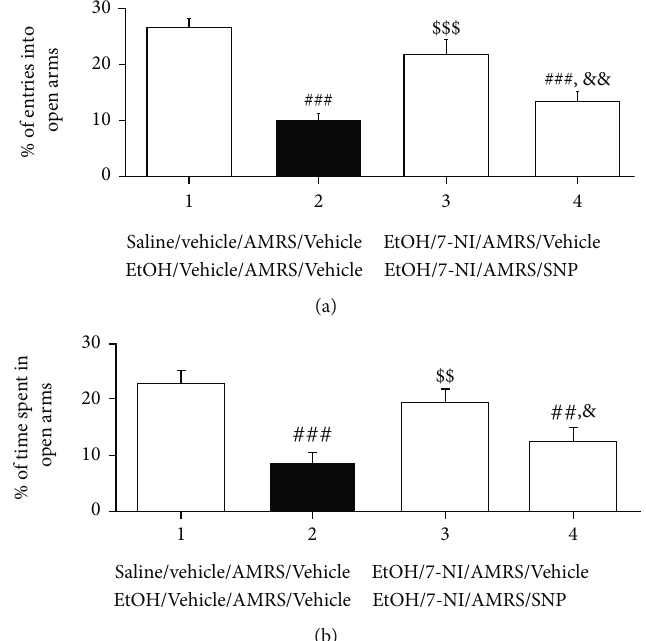
Figure 7: E ff ects of subsequent intra-NTS infusion of SNP on the anxiolytic action of 7-NI. Data are expressed as the mean ± SEM ( n = 6 ). (a) Percentage of numbers of entries into open arms. (b) Percentage of time spent in open arms. ## p < 0 : 01 , ### p < 0 : 001 versus saline/vehicle/ AMRS/vehicle group; $$ p < 0 : 01 , $$$ p < 0 : 001 versus EtOH/vehicle/AMRS/vehicle group; & p < 0 : 05 , && p < 0 : 01 versus EtOH/7-NI/AMRS/ vehicle group.